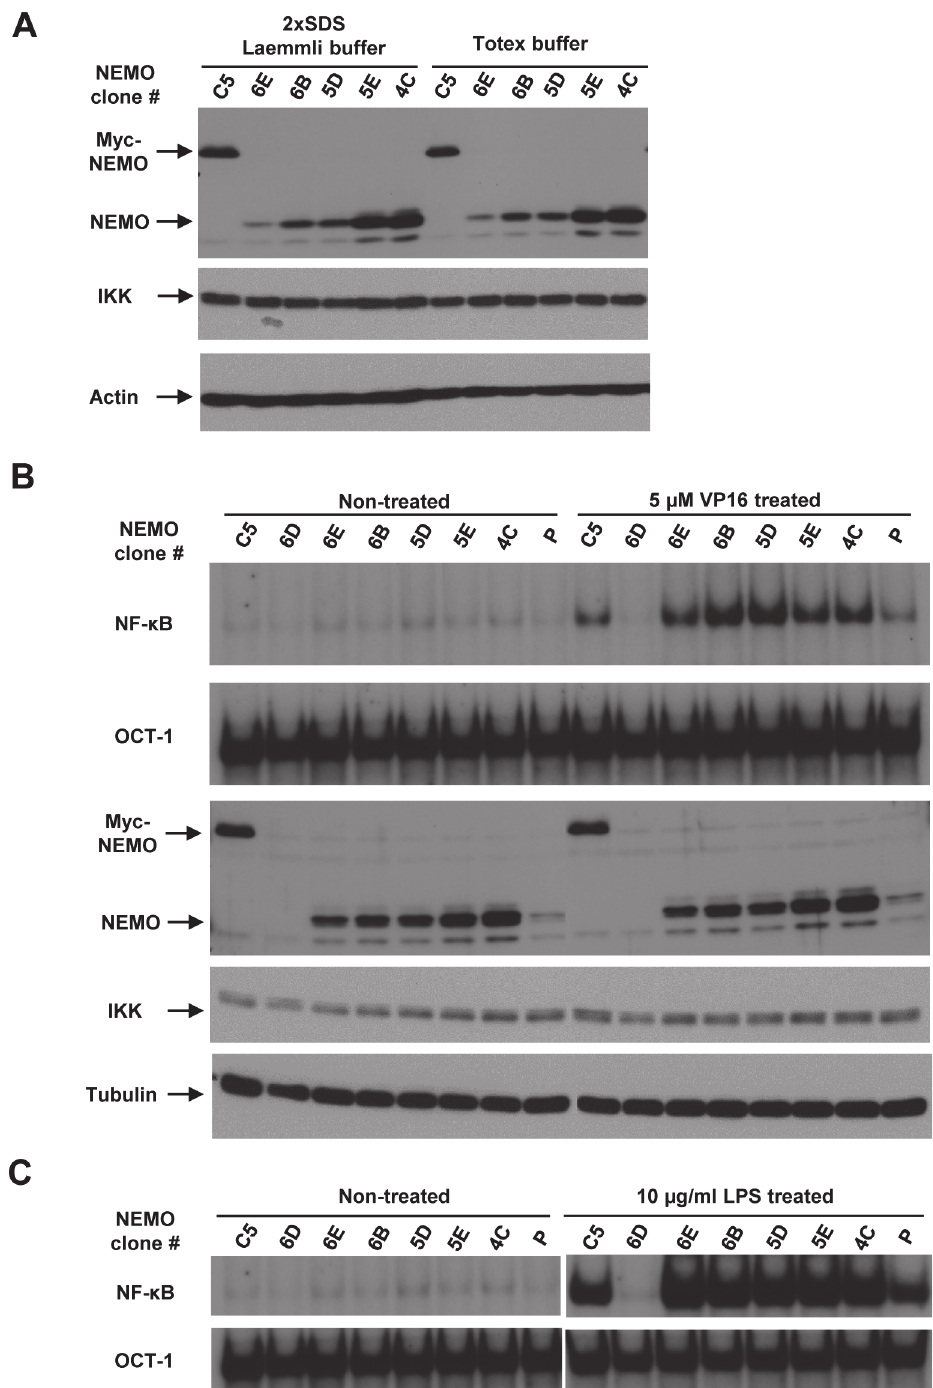
Fig 4. Effects of NEMO amount on NF- κ B activation. (A) Cell extracts from equal numbers of 1.3E2 clones expressing different amounts of NEMO protein were generated using either 2x SDS Laemmli sample buffer or Totex buffer. The cell extracts were separated on SDS-PAGE gel and immunoblotted with NEMO, IKK α / β , and actin antibodies. (B, C) The 1.3E2 clones as in A were left untreated or treated with etoposide (VP16, 5 μ M, 1 hr) in B or LPS (10 μ g/ml, 30 min) in C. P represents pool of the 1.3E2 clones before isolation of individual clones. Protein extracts were examined by EMSA and Western blotting using NEMO, IKK α / β , and tubulin antibodies.